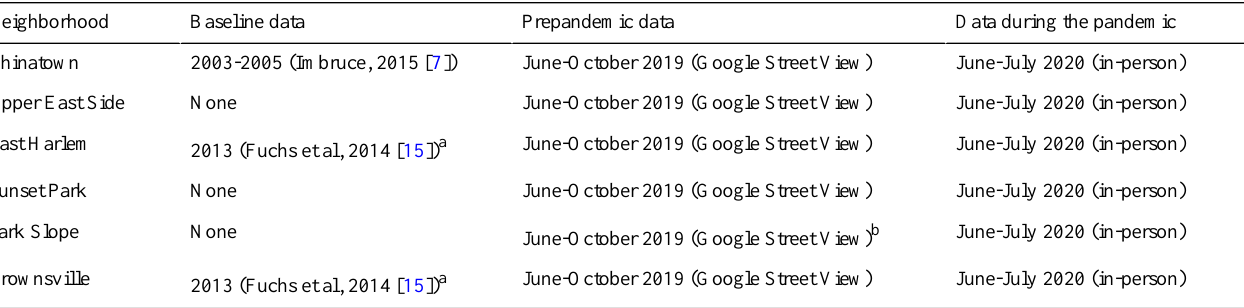
Table 1. Data sources used to assess COVID closures of fresh fruit and vegetable vendors.